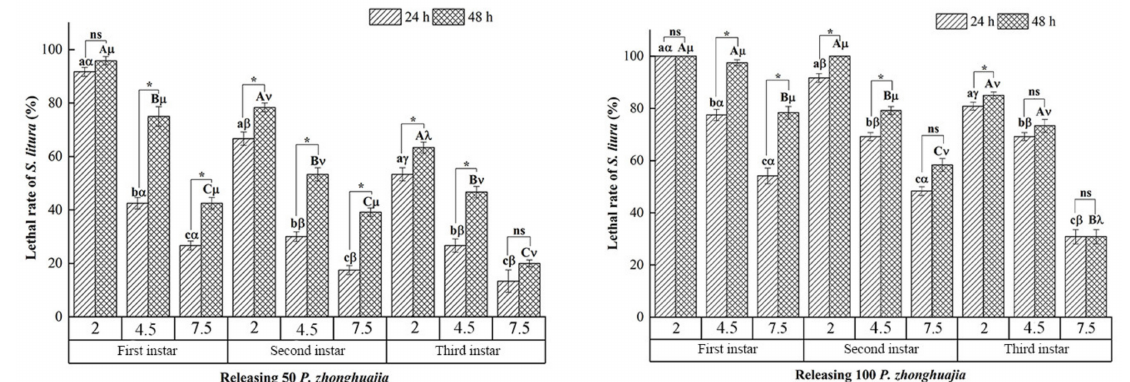
Figure 4. Lethal rates at 24 and 48 h of first, second, and third instar S. litura larvae on tobacco leaves under three different searching ranges (with diameters of 2, 4.5, and 7.5 cm) in the presence of 50 or 100 P. zhonghuajia . All first, second, and third instar S. litura larvae were alive within 48 h in the control without P. zhonghuajia . Different lower-case letters (a–c) and capital letters (A–C) on top of bars indicate significant differences in mortality rates of each S. litura larval stage between 24 and 48 h, respectively (Tukey’s honest significant difference (HSD) test, p < 0.05). The different letters ( α , β and γ ) and ( µ , ν and λ ) on top of bars indicate significant differences in mortality rates of S. litura between 24 and 48 h. An asterisk ( * ) indicates that there was a significant difference in the mortality rates of S. litura between 24 and 48